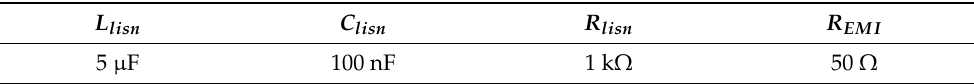
Figure 21. ( a ) Simulated and measured LISN impedance of port 1 ( Z 11 ). ( b ) Comparison of simulated conducted emissions using the equivalent circuit (EC) LISN model from Figure 20 and a vector-fitted (VF) LISN model extracted from 3-port S-Parameter measurements of the LISN. Up to 350 MHz no difference between EC LISN model and VF LISN model can be observed. Table 5. Parameters of the LISN model depicted in Figure 20. The parameter values were taken from the datasheet [19], and the parameter R EMI describes the input resistance of the connected measurement equipment (EMI receiver).